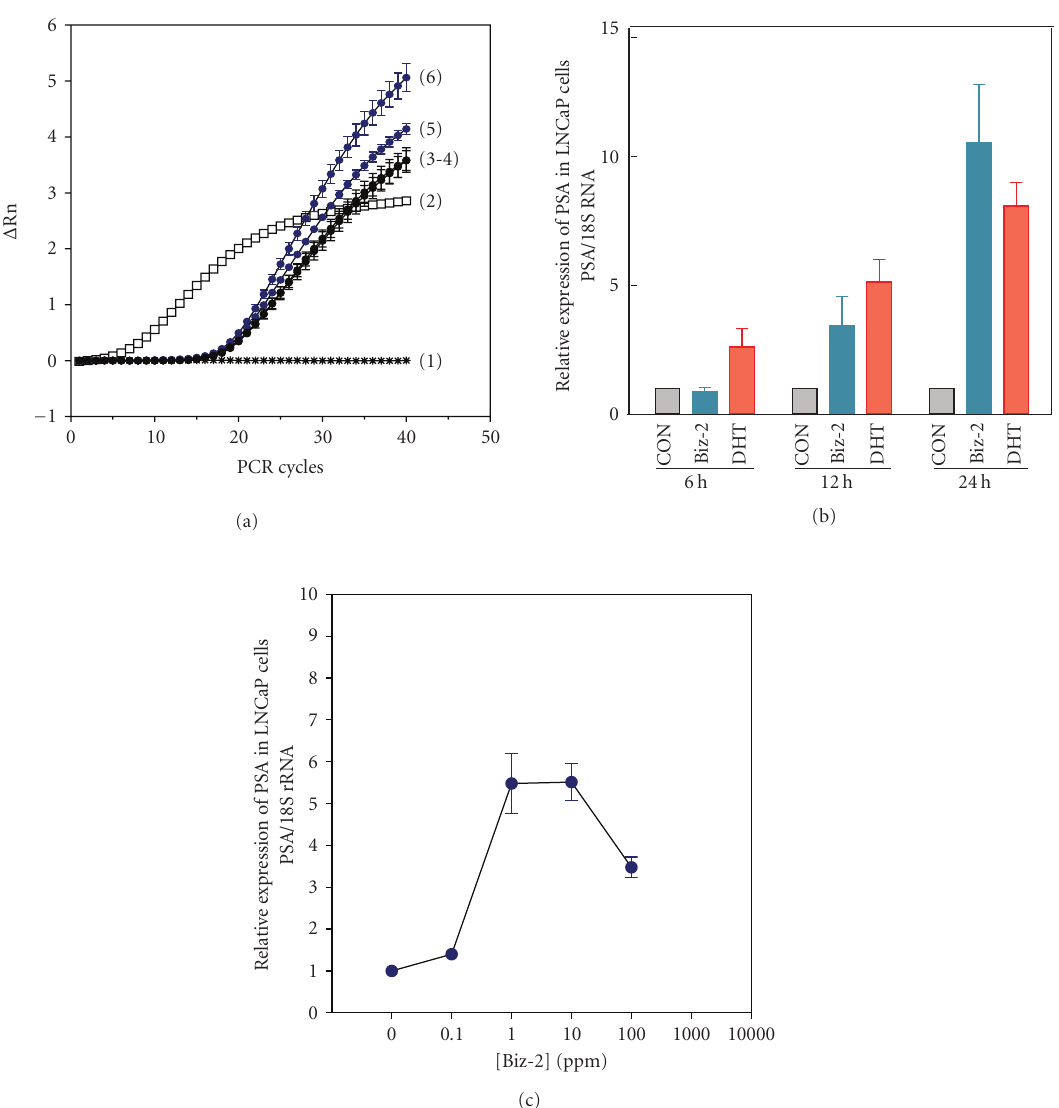
Figure 2: Stimulation of PSA mRNA expression by Biz-2. LNCaP cells were induced with Biz-2 or DHT, and 5 μ g of DNase-I-treated RNA isolated from induced or uninduced cells were subjected to two-step Taqman real-time RT-PCR (see Section 2). The relative expression of PSA mRNA expression was calculated by the 2 ΔΔ Ct method. First, relative quantitation of PSA mRNA expression was performed by first normalizing the C t values of PSA amplification against the C t values of endogenous 18S rRNA, then the resulting C t values were normalized using the C t value of the vehicle control sample. (a) Relative amplification plot of mRNA expression (1–NTC. 2–18S rRNA at 24 hours, 3 and 4- CON at 6 and 24 hours, 5 and 6- Biz-2 at 6 and 24 hours). (b) PSA mRNA expression relative to time. (c) Dose-dependent response of PSA to Biz-2. The values are mean ± SEM of induction samples analyzed in